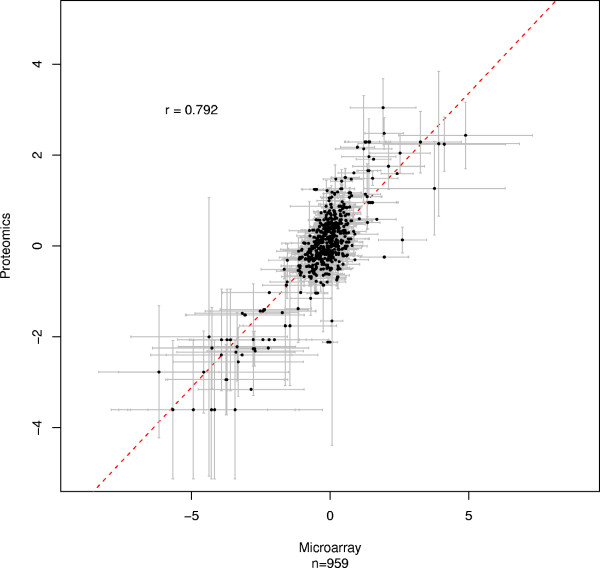
High correspondence between protein and transcript level summary averages in exon array data. Each point corresponds to a transcript matched by at least one peptide and at least one array probeset. X and Y axes: fold-changes between MCF7 and MCF10A for the microarray-probeset and quantitative-peptide data, respectively. When more than one matching peptide/probeset was found, the mean value was calculated. Error bars represent one standard deviation. r: Pearson correlation. n: number of data points.